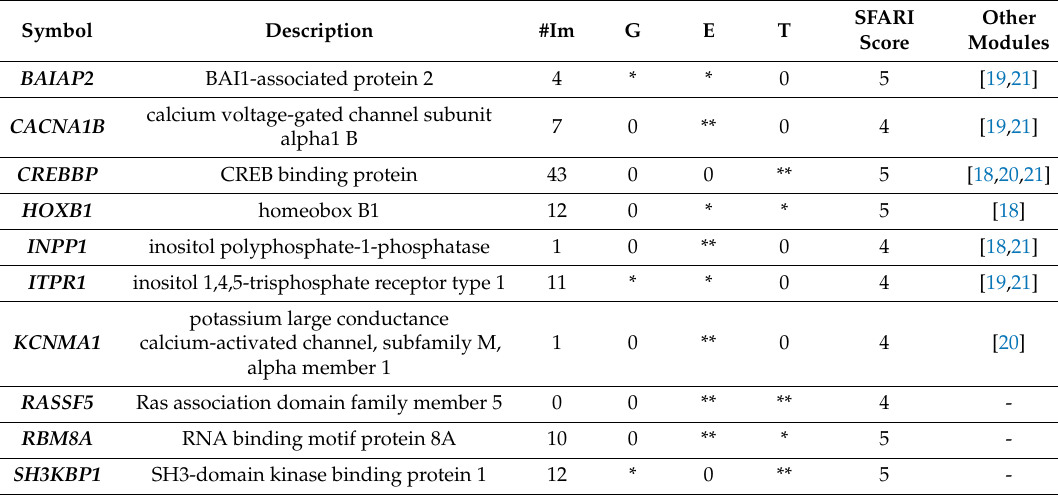
calcium voltage-gated channel subunit